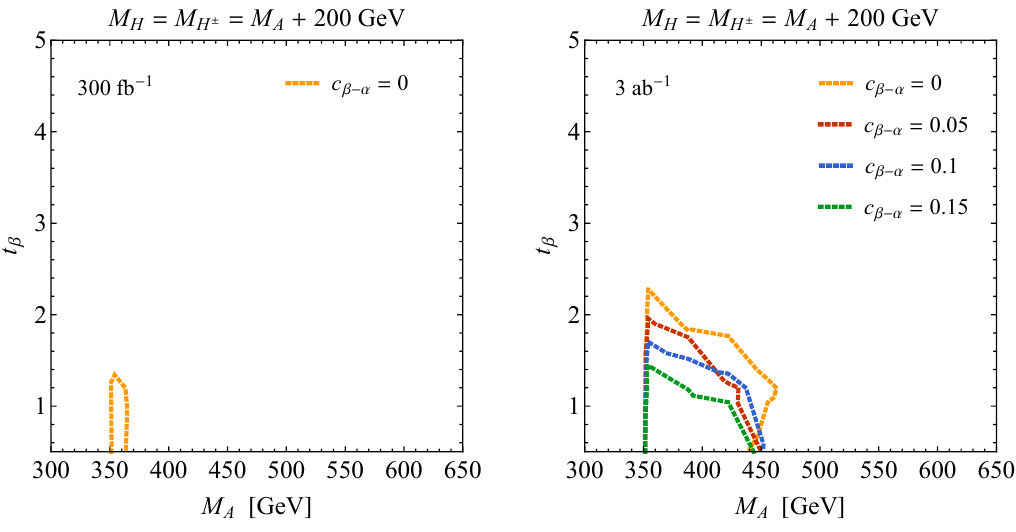
Figure 13 . The 5 (cid:27) discovery reach on t (cid:12) in the type-II 2HDM resulting from a (cid:1) m shape (cid:12)t. The used integrated luminosities and the choice of parameters is identical to that of (cid:12)gure 10. that the HL-LHC may be able to discover all mass combinations f M ; M g inside a H=A A=H region spanned by the points f 450 ; 350 g GeV, f 1000 ; 500 g GeV and f 1150 ; 350 g GeV, while for M = min ( M ; M ) only heavy neutral Higgs bosons with masses in the range of H A H (cid:6) [450 ; 750] GeV can potentially be discovered if M = 350 GeV. Notice that the quoted 5 (cid:27) A=H HL-LHC limits are similar to the 95% CL exclusions obtained in section 8 for LHC Run-3. Figure 13 displays in addition the discovery reach in the M { t plane for the A (cid:12)